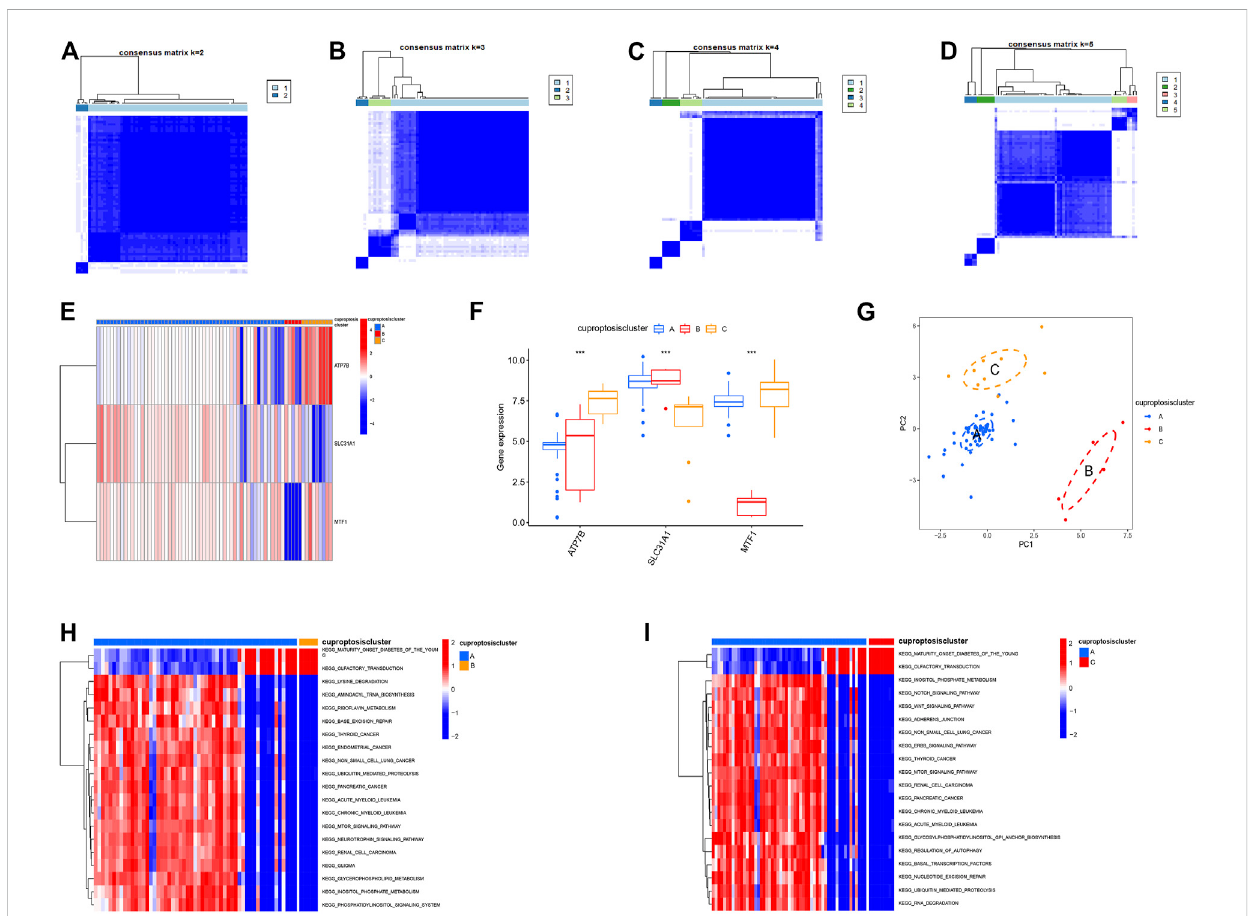
FIGURE 5 The consensus clustering analysis of cuproptosis regulators. (A – D) Consensus matrices of the three signi fi cant cuproptosis regulators for k = 2 – 5, (E) Expressionheatmapofthethreesigni fi cantcuproptosis regulators inclusterA,clusterBandclusterC, (F) Differential expression histogram ofthethree signi fi cant cuproptosis regulators in clusterA, clusterB and clusterC. (G) Principal component analysis for the expression pro fi les of the three signi fi cant cuproptosis regulators. (H,I) GSVA showed that ClusterA was signi fi cantly enriched in oncogenic pathways, and clusterB and clusterC were mainly associated with diabetes and olfactory conduction in young